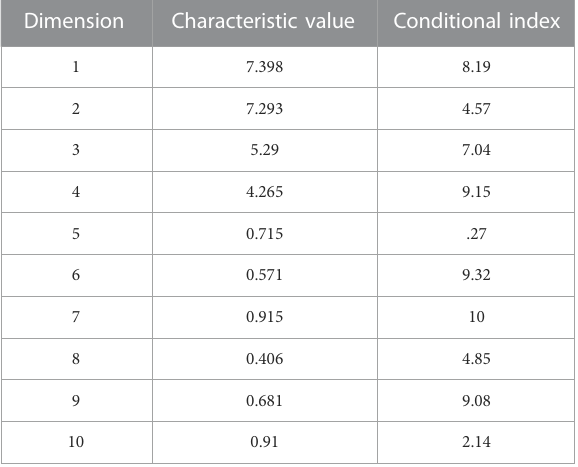
TABLE 3 Collinearity diagnosis.